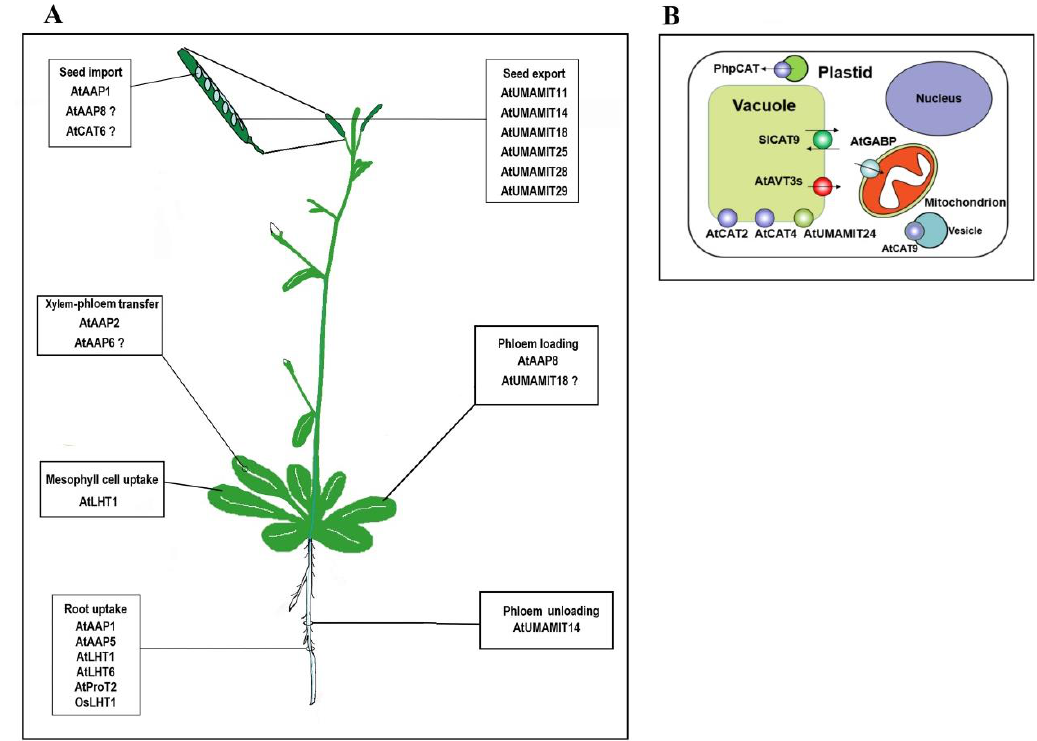
Figure 1. Overview of the function of amino acid transporters identified in plants. ( A ) Summary of transporters involved in intercellular and long-distance transport of amino acids. Some genes that were proposed to participate in certain amino acid transport steps are marked with question marks due to lack of direct evidence. ( B ) Summary of transporters involved in intracellular transport of amino acids. Transporters with defined transport direction are marked with black arrows. References on these genes depicted in the figure can be found in the main text.